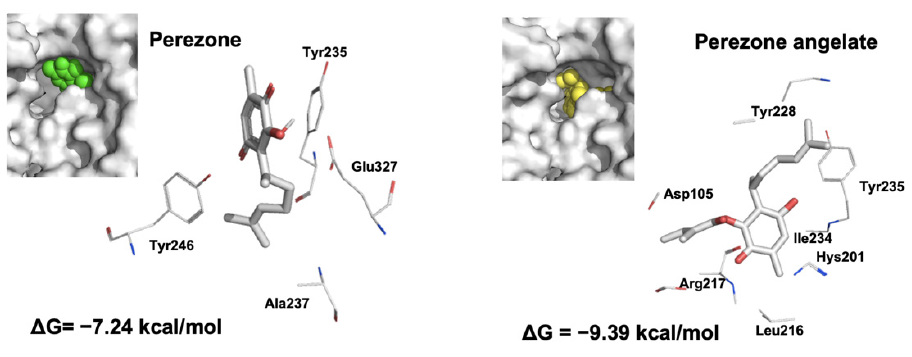
Figure 7. Non-bonding interactions established by perezone and perezone angelate with PARP-1, demonstrated by docking studies, the volume occupied by each compound in the catalytic site of PARP-1 is shown at the left of each image. Perezone angelate showed the highest affinity; the presence of its angelic substituent allowed it to present a different binding mode and exhibit higher affinity than perezone.